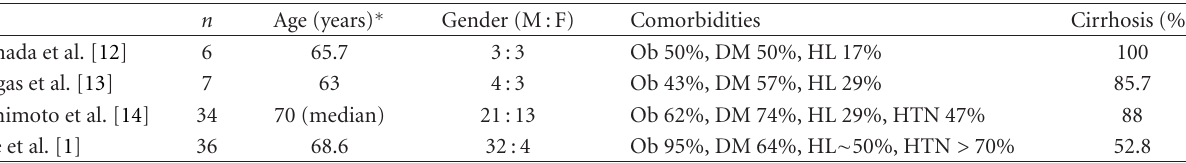
Table 1: Series of NASH-associated HCCs ( ≥ 5 patients).